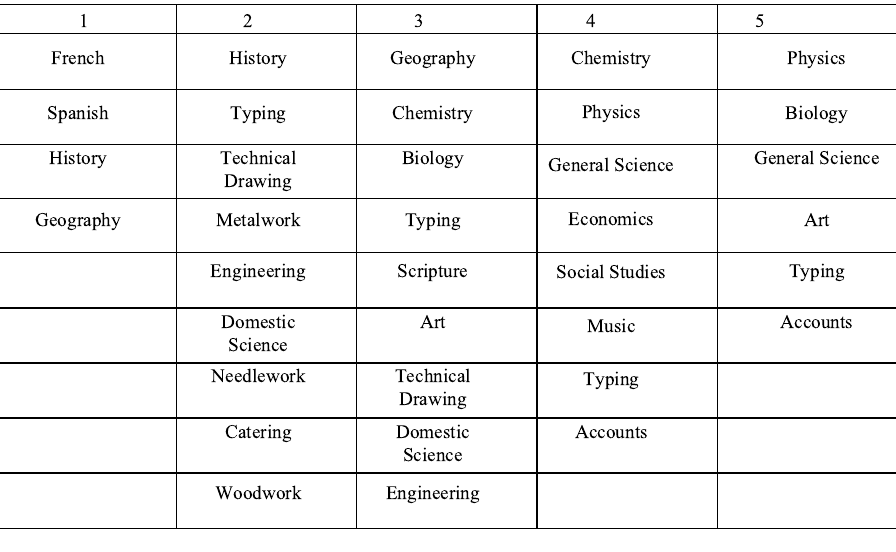
Figure 1. Subject pools for options in the fifth year in a large 11–18 comprehensive school (modified from Benn & Simon,